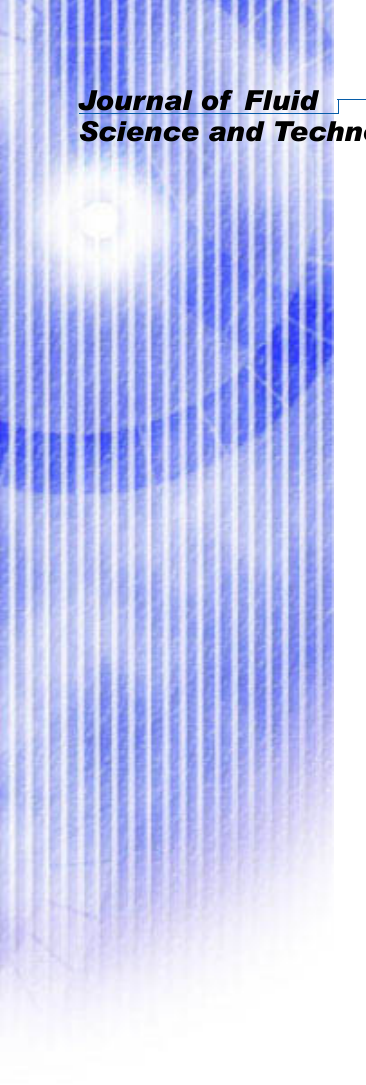
: (a) standard solution; (b) ordinary simulation; m = 100 %, F = 100 Hz); (d) PIV-MI f = 100 %, F = 7 Hz); (e) PIV-MI f = 7 %, F = 100 Hz). f